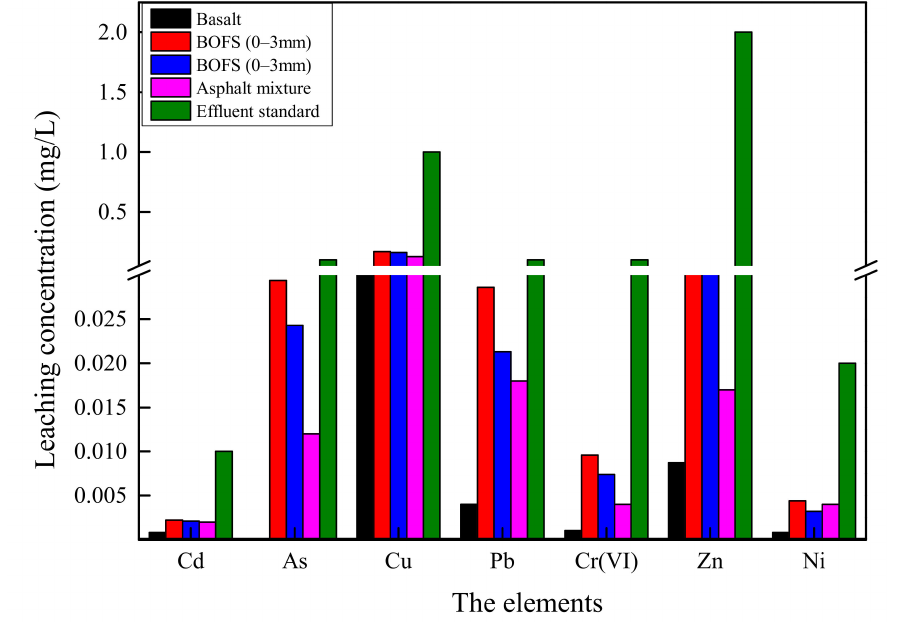
Figure 5. The leaching results of toxicity characteristic leaching procedure (TCLP) test from BOFS, basalt and asphalt